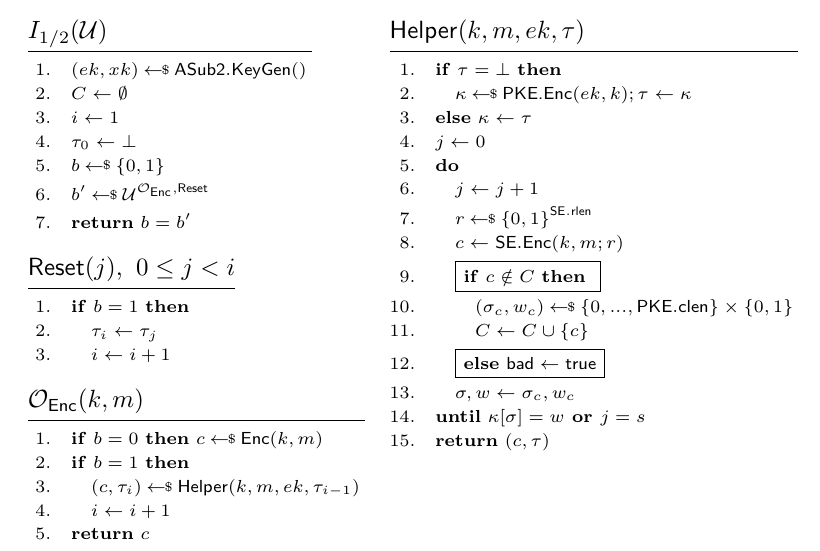
Figure 11: Games I 1 and I 2 for the proof of Theorem 3. Game I 1 contains the boxed code while game I does not (including the appropriate indentation 2